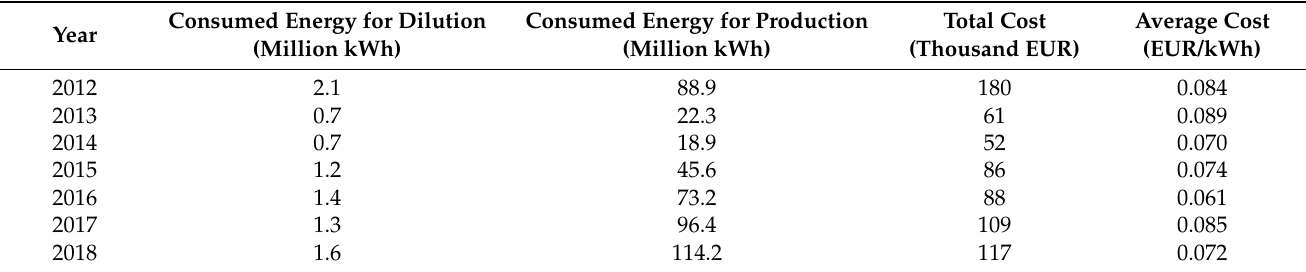
Table 1. Energy consumed for dilution and production, total dilution cost, and annual mean price of energy supplied or used for dilution.